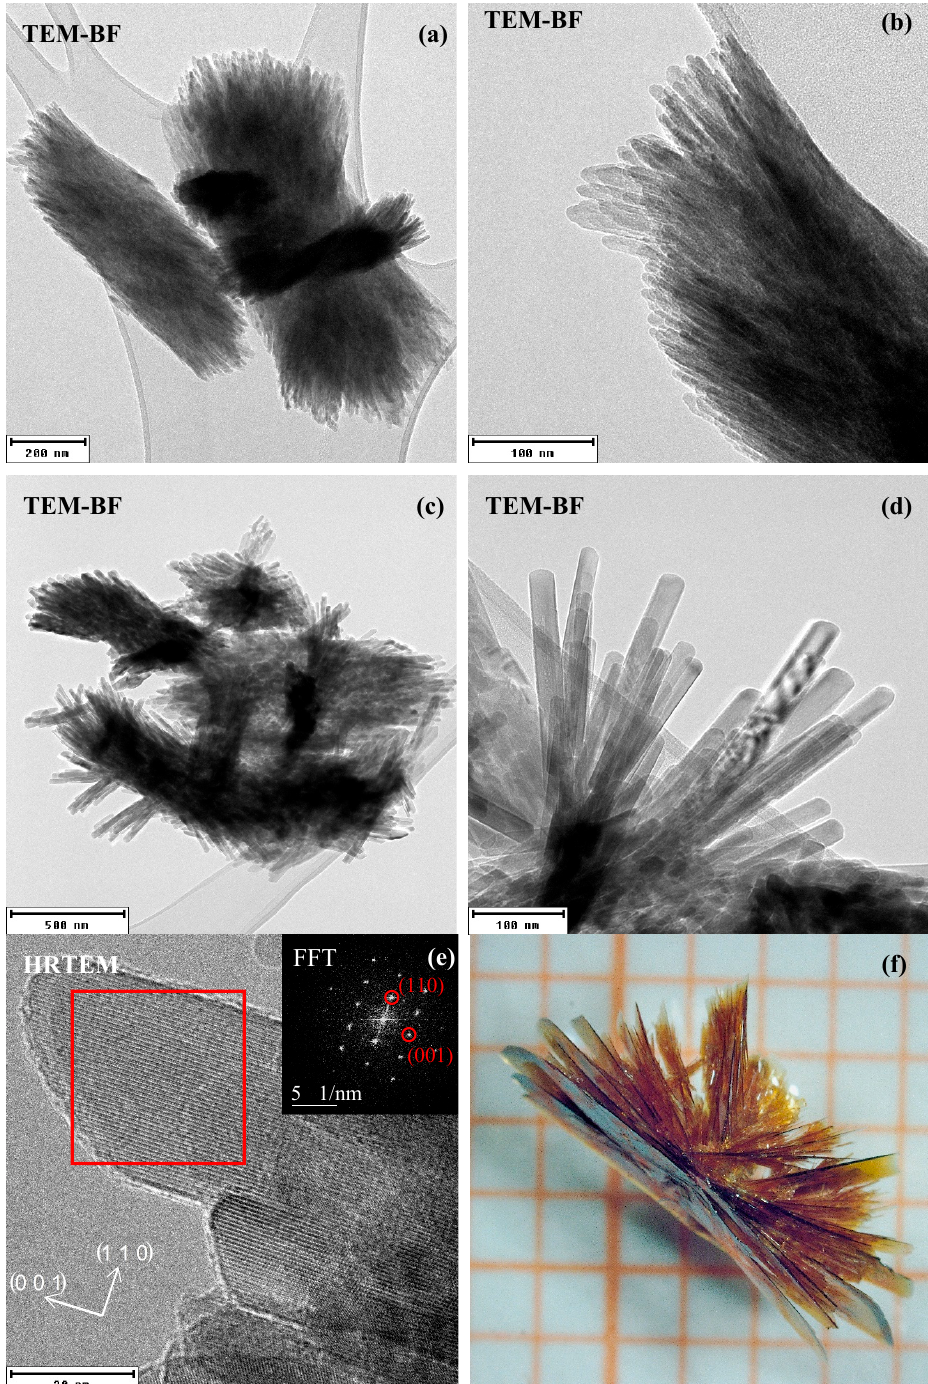
Figure 2. Bright field Transmission electron microscopy images of aegirine NaFeSi 2 O 6 , grown at 160 °C ( a , b ) and 220 °C ( c – e ) The crystallographic orientation of the crystallites was identified via Fast Fourier Transform (FFT) from the region marked with the red square in the High Resolution TEM image (HRTEM) ( e ) The image in ( f ) is an optical microscope photograph of an aegirine aggregate, synthesized as macro-crystals via flux growth, the grid size is 1 × 1